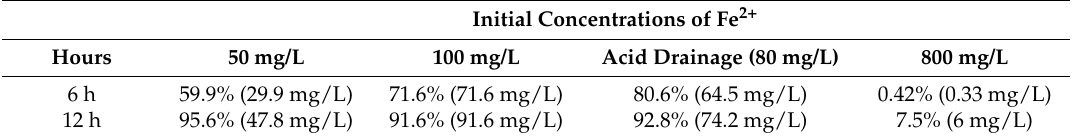
Figure 4. Growth of the microalga Muriellopsis sp. in NAD (80 mg/L of iron, pH 4 and salinity 35 ‰ ). Diamond symbol microalgal growth. Table 2. Iron removal from AAD by the microalga Muriellopsis sp.